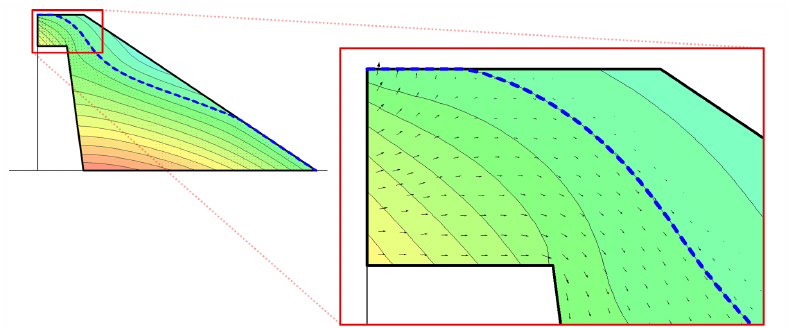
Figure 11. Detail showing flux vectors at the crest of the no toe configuration for q = 4.0 × 10 − 3 m 3 /s. The maximum flux shown in the top left corner is 0.0068 m 3 /s/m 2 ; the vectors are magnified by a factor of two to increase